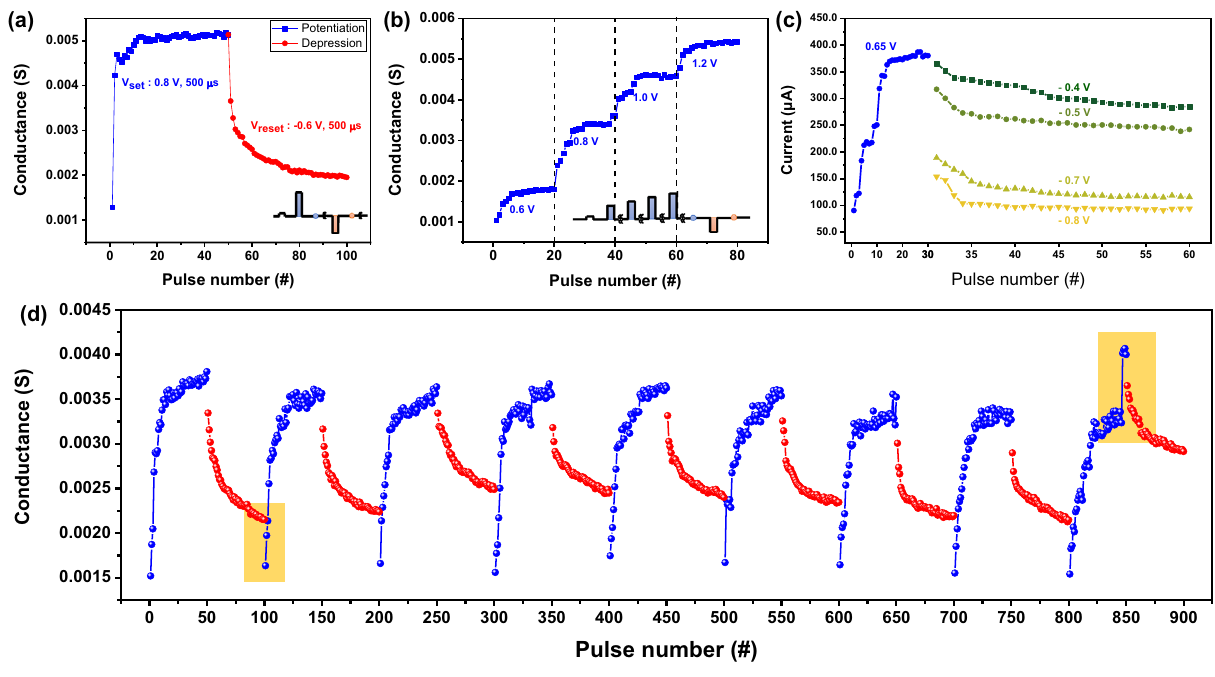
Figure 5. Synaptic behaviors of the Ag/ZnO/TiN device. ( a ) Potentiation and depression characteristics with a set pulse (0.8 V, 500 μs) and a reset pulse (− 0.6 V, 500 μs). ( b ) Gradual stepwise increase in conductance via an incremental pulse scheme. ( c ) Conductance modulation by varying the reset pulse voltage. ( d ) Multiple potentiation and depression